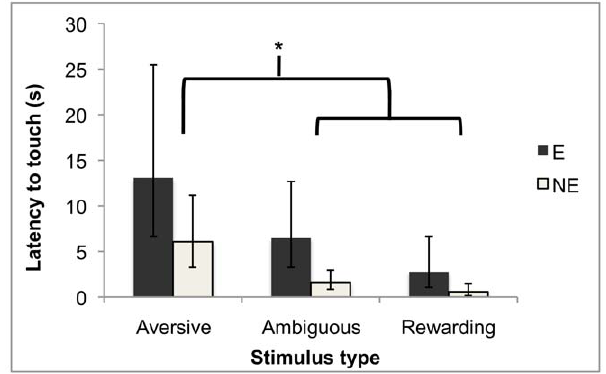
Figure 1. Latency to make contact with the stimulus, split by housing treatment and stimulus type. Data are back-transformed least squares means, with error bars indicating confidence intervals. * indicates a significant difference at the a =0.05 level. There was also a significant main effect of housing treatment. A version of this figure based on earlier statistical models was included in Meagher [81].